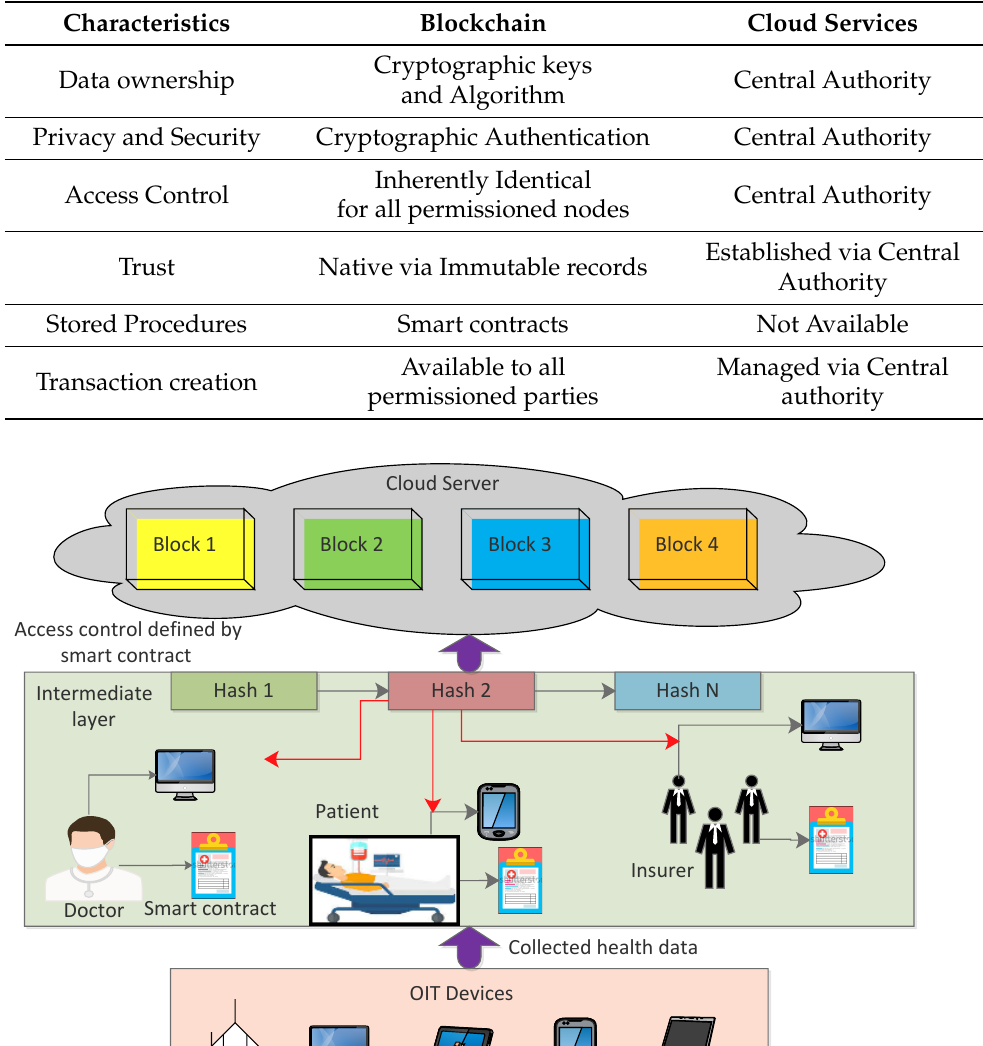
Table 2. Comparison between blockchain and IoT/ cloud services.